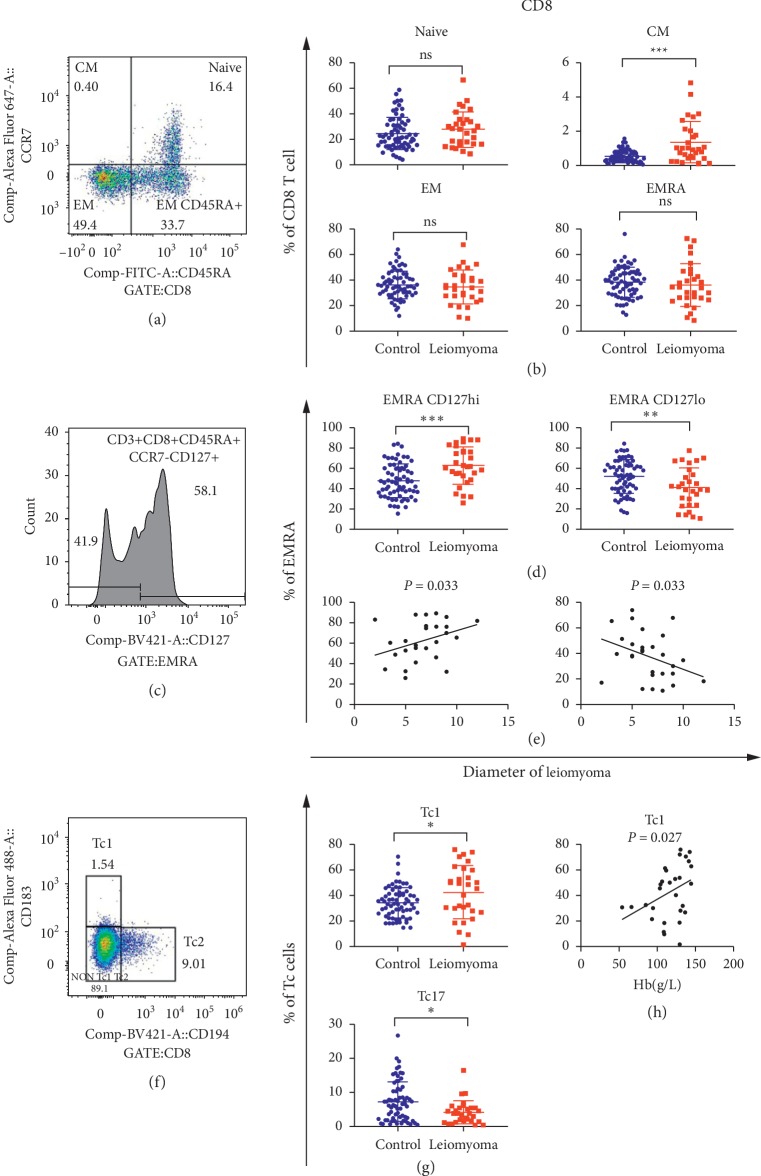
CD8+ cells, its subgroups, and diameter of leiomyoma. (a, c, f) The flow analyses of CD8+ naïve, CM, EM, EMRA, EMRA CD127high/low cells, and Tc cells, respectively. (b, d, g) The comparison of above cells between 30 patients and 68 controls. (e) Association between CD8+ EMRA CD127hi/lo cells with the diameter of leiomyoma in 30 patients. (h) Association between Tc1 cells and hemoglobin (Hb) in 30 patients. ∗P < 0.05. ∗∗P < 0.01. ∗∗∗P < 0.001. ns, not significant.